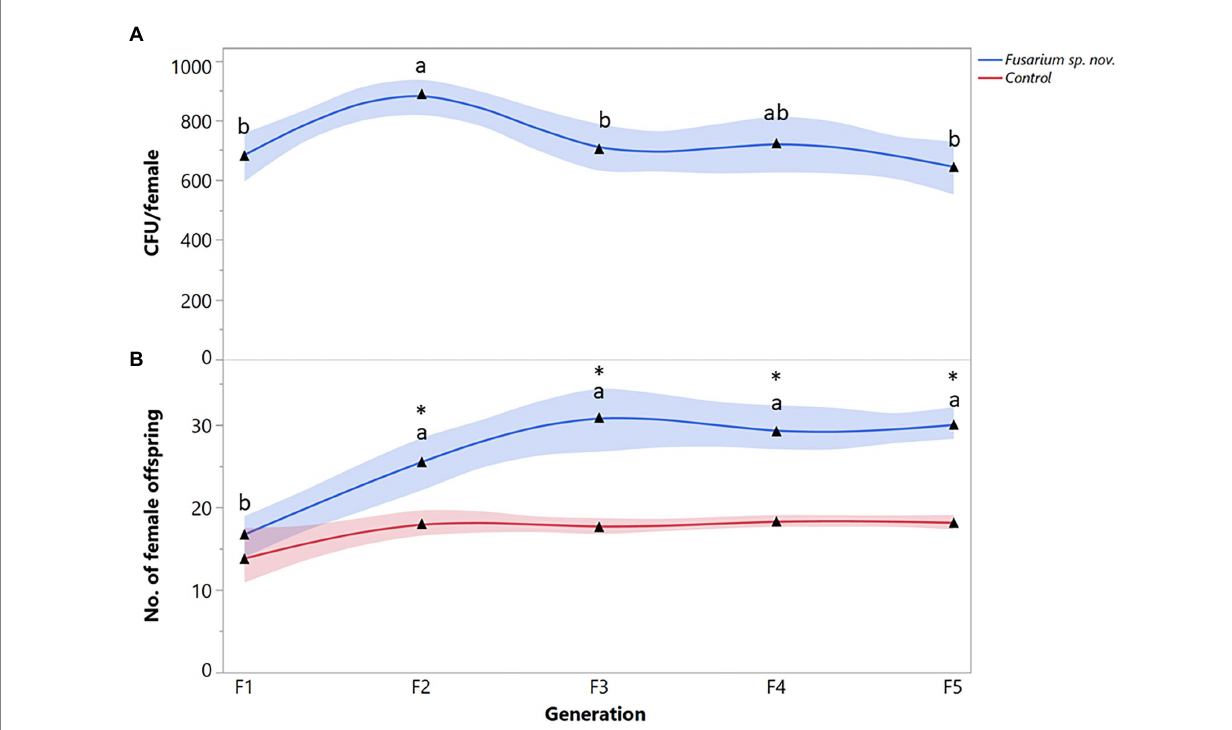
FIGURE 4 Xyleborus bispinatus performance with a single mutualistic fungus ( Fusarium sp. nov.). (A) Mean number of CFUs ( ▲ ) recovered from single female offspring per generation and (B) Mean number of female offspring ( ▲ ) produced by single female founder per generation. Same letters within the same color are not significantly different (Tukey HSD, α = 0.05). Asterisks show significant differences in female offspring between fungal symbiont and control within generation (Kruskall-Wallis, α = 0.05).